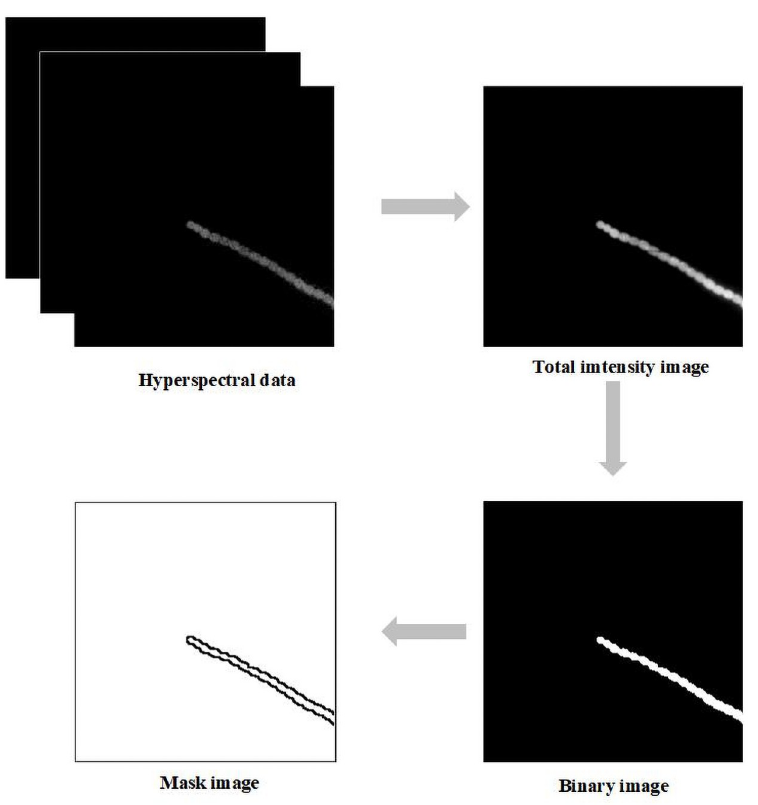
Fig 2. Image preprocessing. After image reconstruction, an integral method was used to accumulate the total intensity in each image of the data file. Binary values are used to replace the pixel values of the region of interest with one and replace the pixel values of background with zero. Finding edges based on binary images generates a mask image.